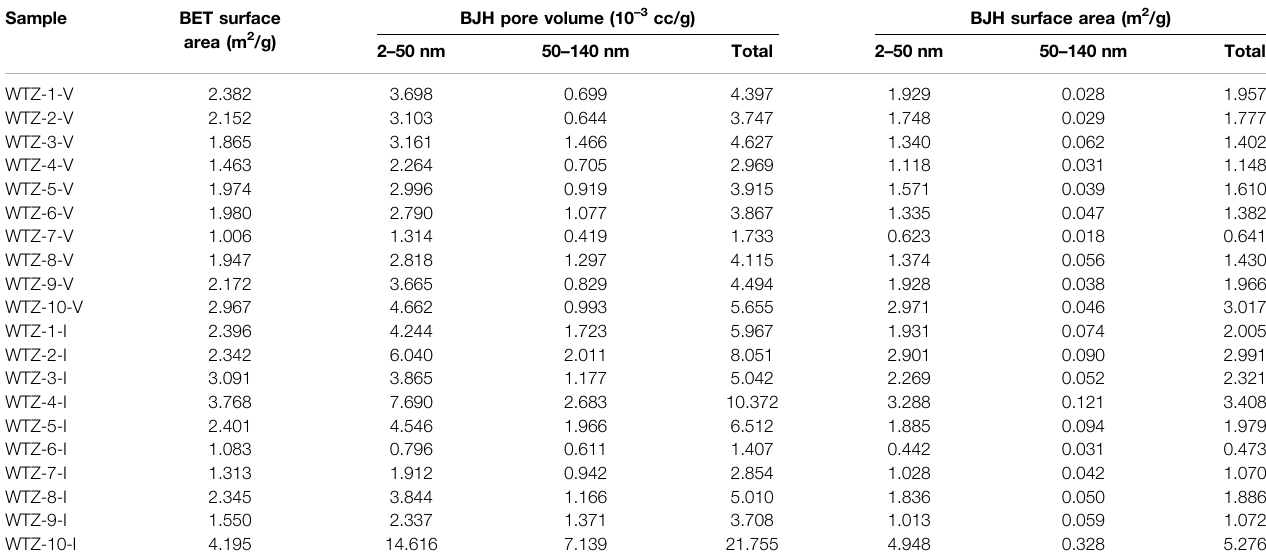
TABLE 3 | Result of N 2 adsorption/desorption experiments.